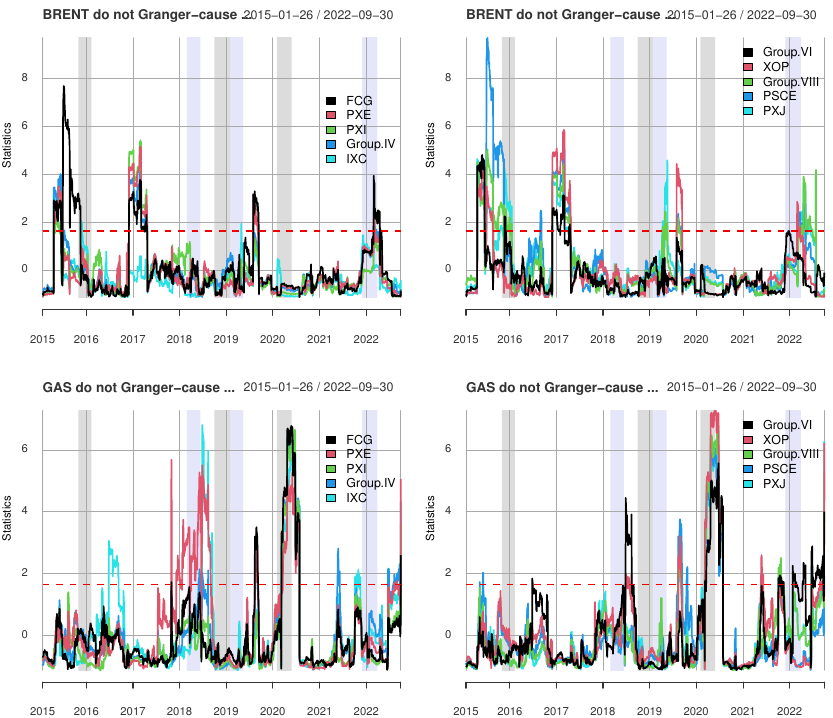
Figure 4. Rolling Hong tests between crude oil, natural gas and ETFs (causality-in-variance). The red dashed line indicates the critical value of the H 1 test at the 5% significance